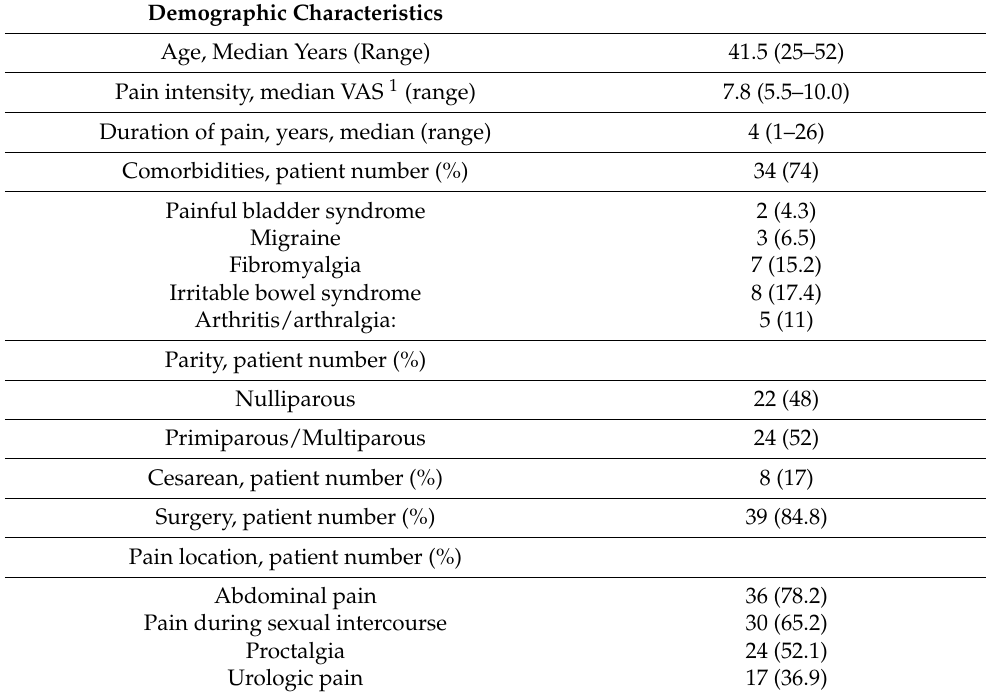
Table 1. Demographic characteristics of patients with endometriosis patients unresponsive to con- ventional therapy.